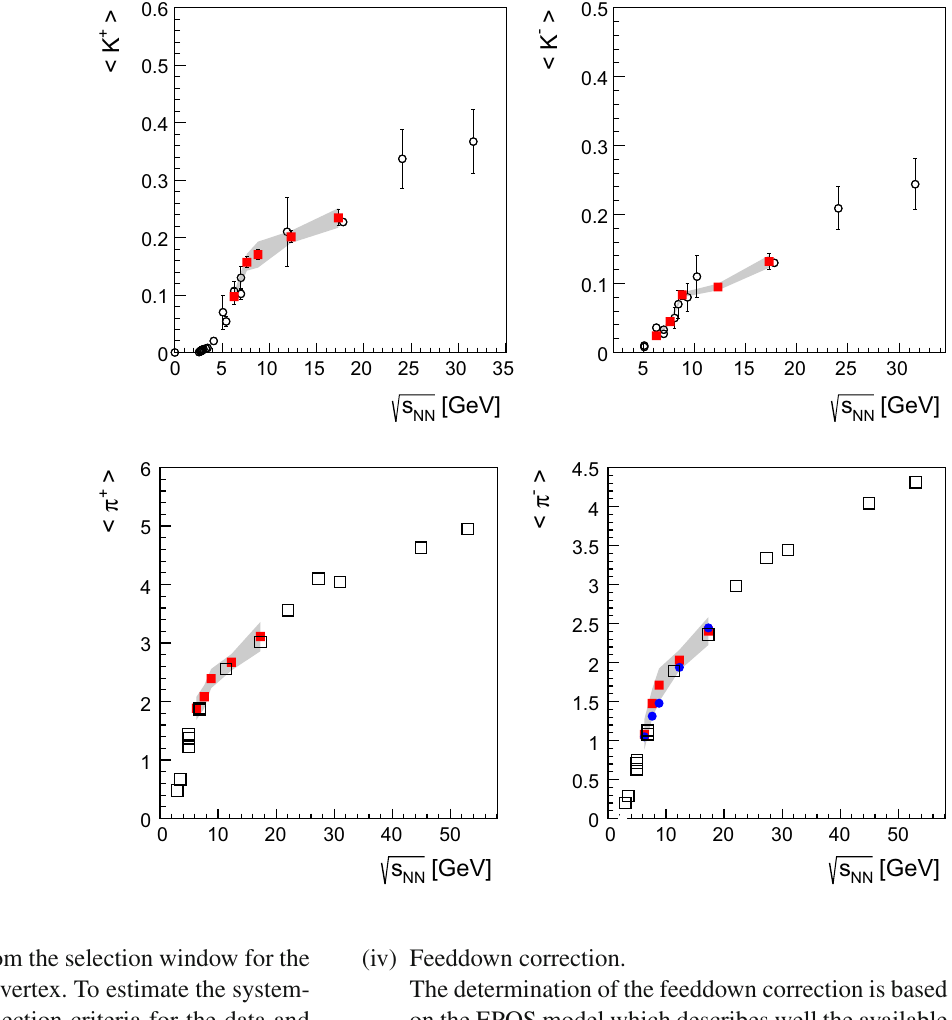
Fig. 37 Mean π + (left) and π − (right) multiplicity produced in inelastic p + p interactions as function of collision energy. Measurements of NA61/SHINE for identified pions are plotted as filled red squares, whereas those obtained by the h − method [3] by blue dots. Black open squares represent the world data [11,37–44]. Statistical uncertainties are indicated by bars, systematic uncertainties of the NA61/SHINE measurements by shaded bands